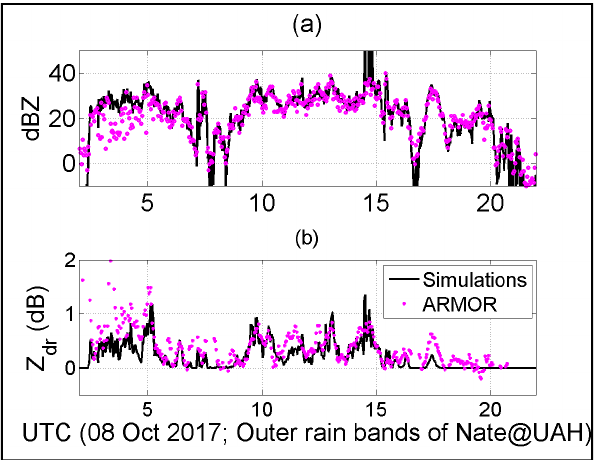
Figure 9. ( a ) Reflectivity and ( b ) Z dr calculations derived from the individual drop scattering amplitudes using the 2DVD measurements (in black) compared with the C ‐ band dual ‐ polarization radar (ARMOR) radar measurements (magenta) over the 2DVD site. For the former, 1 ‐ min time interval is used.